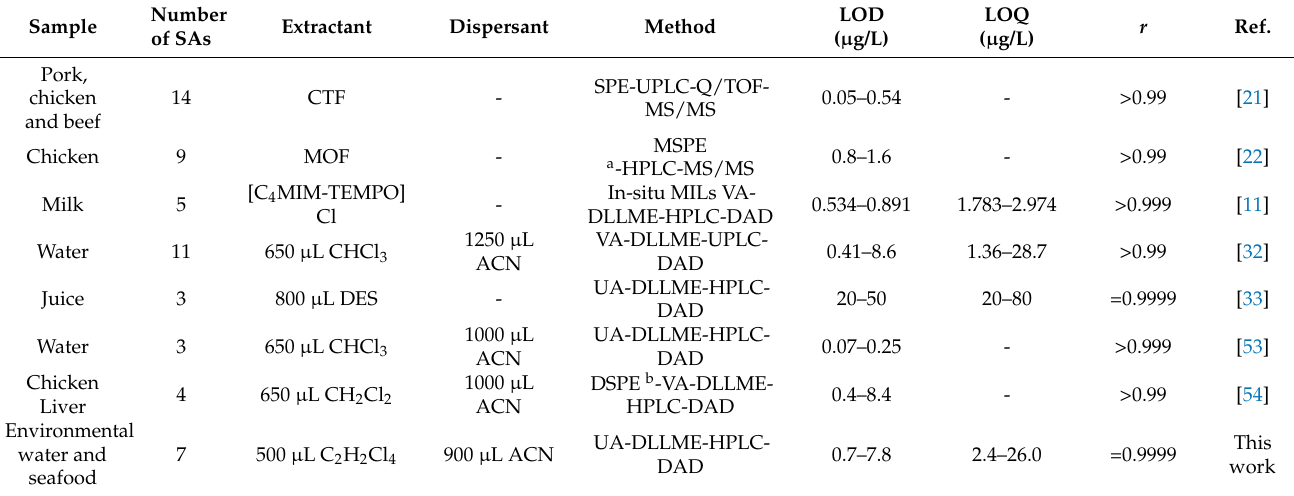
Table 3. Analytical performance comparison with reported methods for SAs